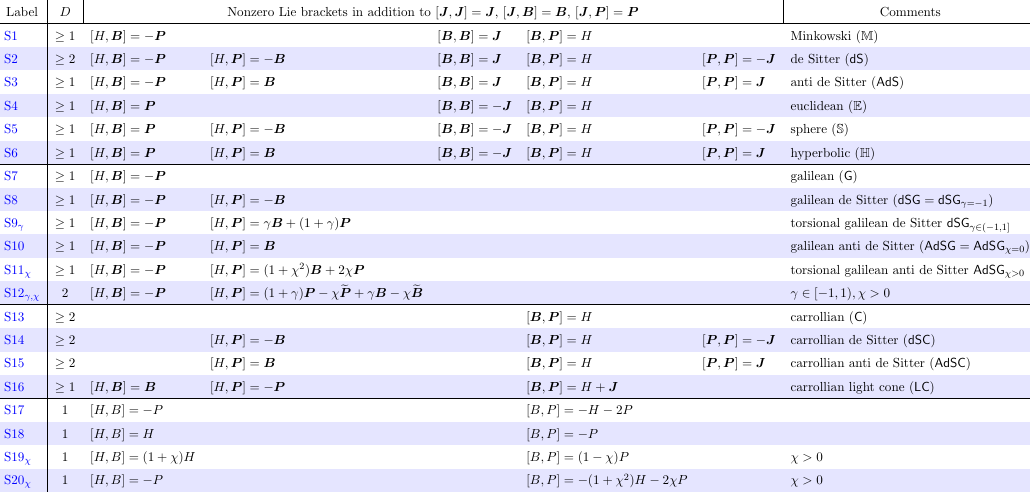
Table 1 . Simply-connected homogeneous ( D +1)-dimensional kinematical spacetimes.